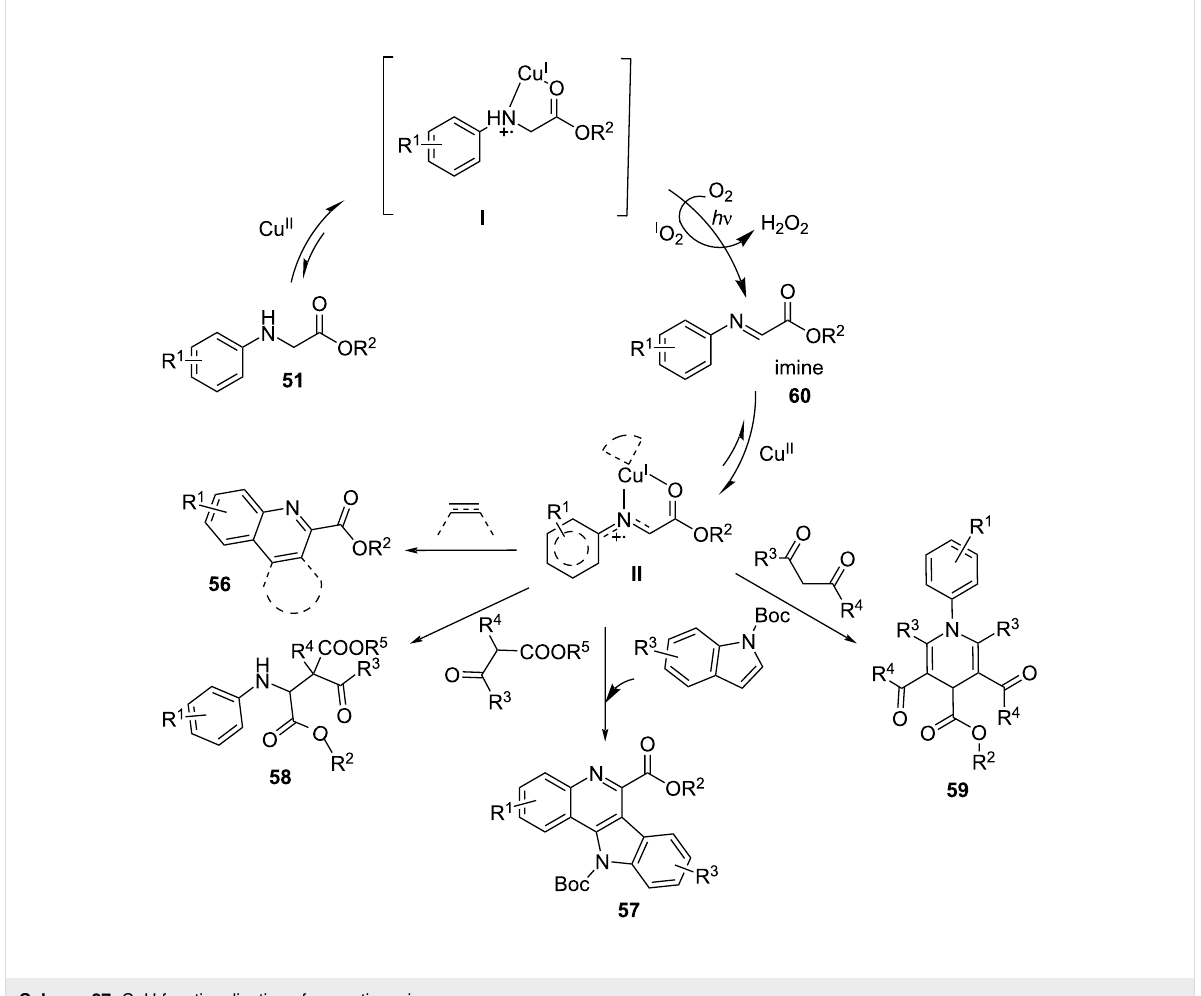
Scheme 27: C–H functionalization of aromatic